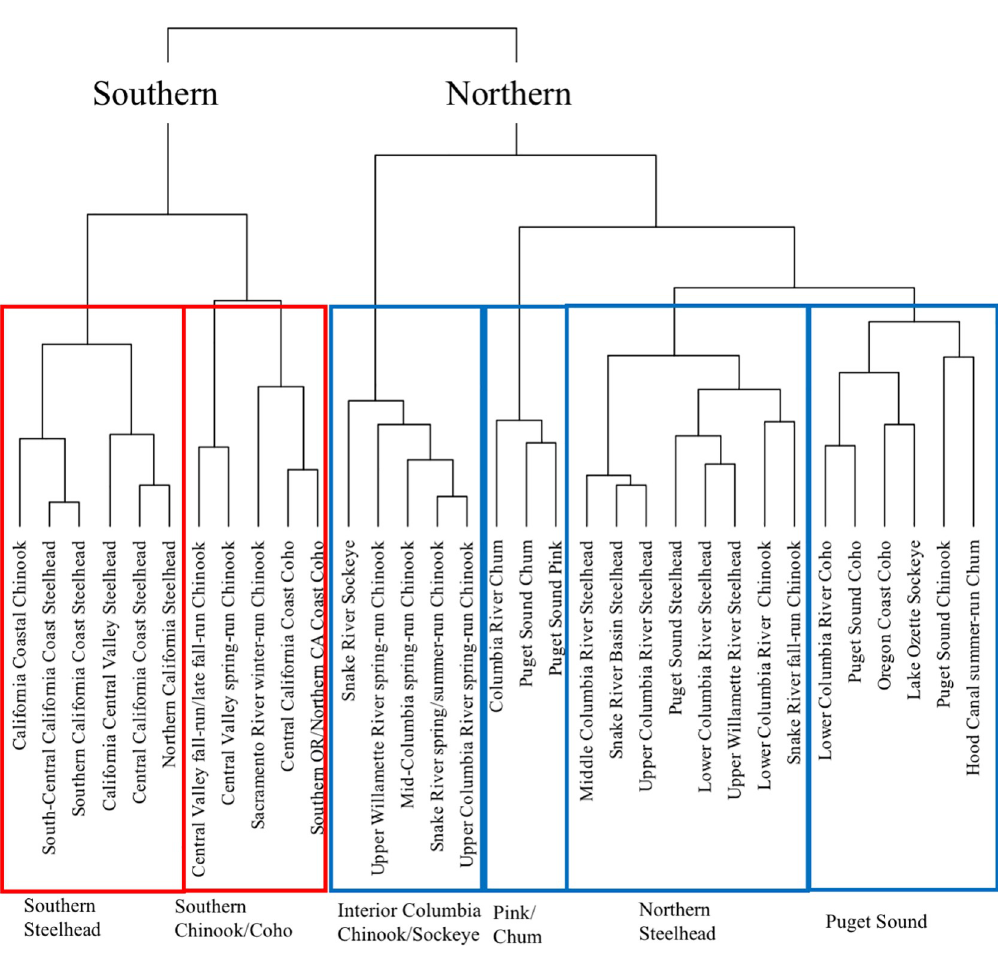
Fig 7. Cluster dendrogram based on attribute scores for each DPS. Groupings that define each cluster are outlined with red (southern) and blue (northern) boxes, with the cluster name below each box.